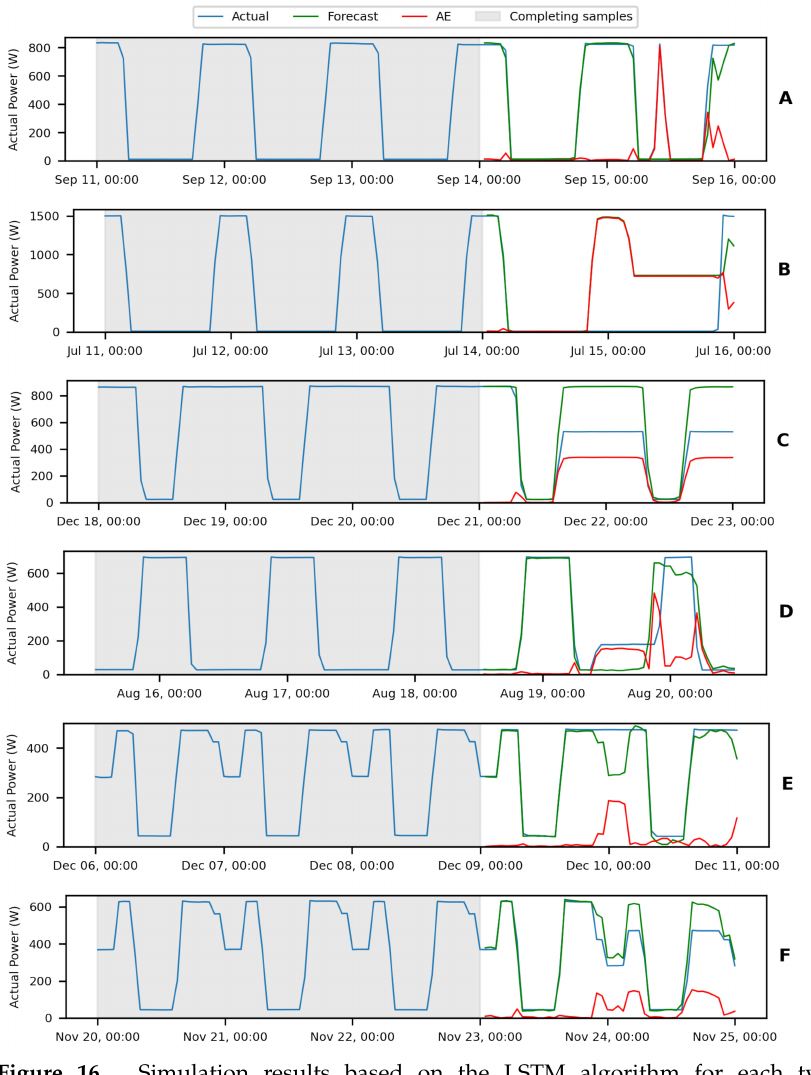
Figure 16. Simulation results based on the LSTM algorithm for each type of anomaly. Subfigures ( A – F ) correspond to anomalies discussed in Section 3. To enhance readability the sample collection period is shown as shorter than it actually